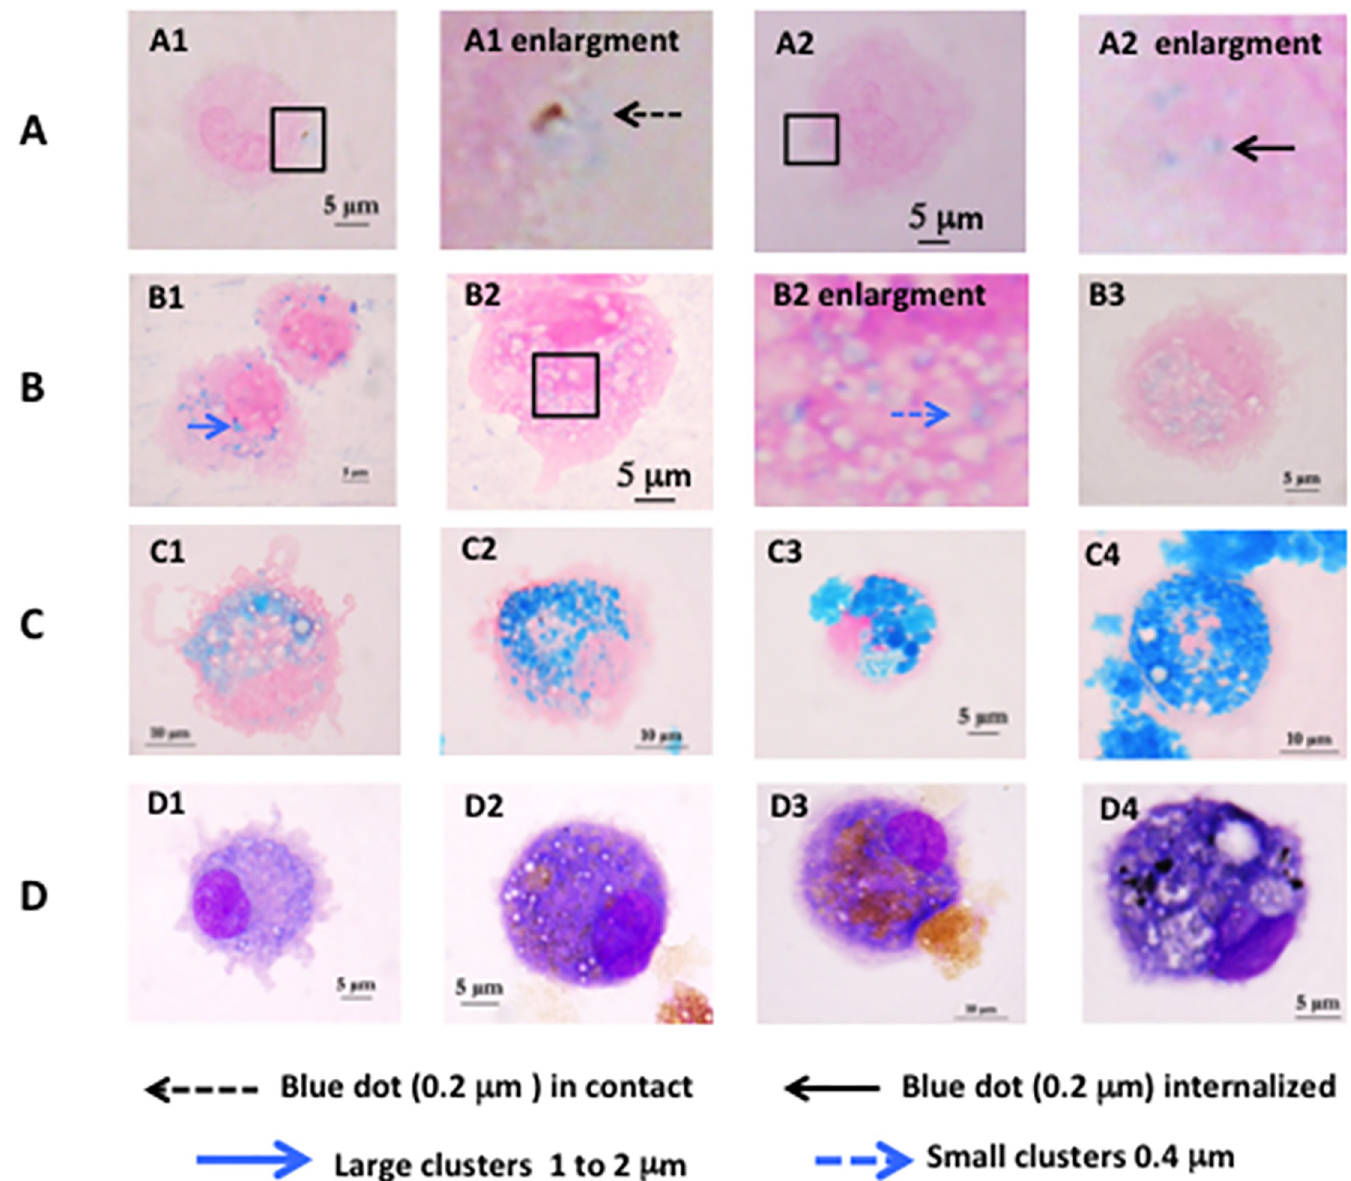
Fig 2. Nanoparticles internalization in cMoDCs observed with Perls staining (A) to (C) and MGG staining (D). (A) after 2h of incubation (A1) with NPs-MPLA 0.1% or (A2) Blank-NPs. (B) after 24h of incubation (B1) with Blank-NPs, (B2) NPs-MPLA 0.1%, (B3) NPs-MPLA 0.025%. (C) after 48h of incubation (C1) with NPs-MPLA 0.025%, (C2) NPs-MPLA 0.05%, (C3) NPs-MPLA 0.1%, (C4) NPs-MPLA 0.2%. (D) after 48 of incubation with (D1) with NPs-MPLA 0.025%, (D2) NPs-MPLA 0.05%, (D3) NPs-MPLA 0.1%, (D4) NPs-MPLA 0.2%.